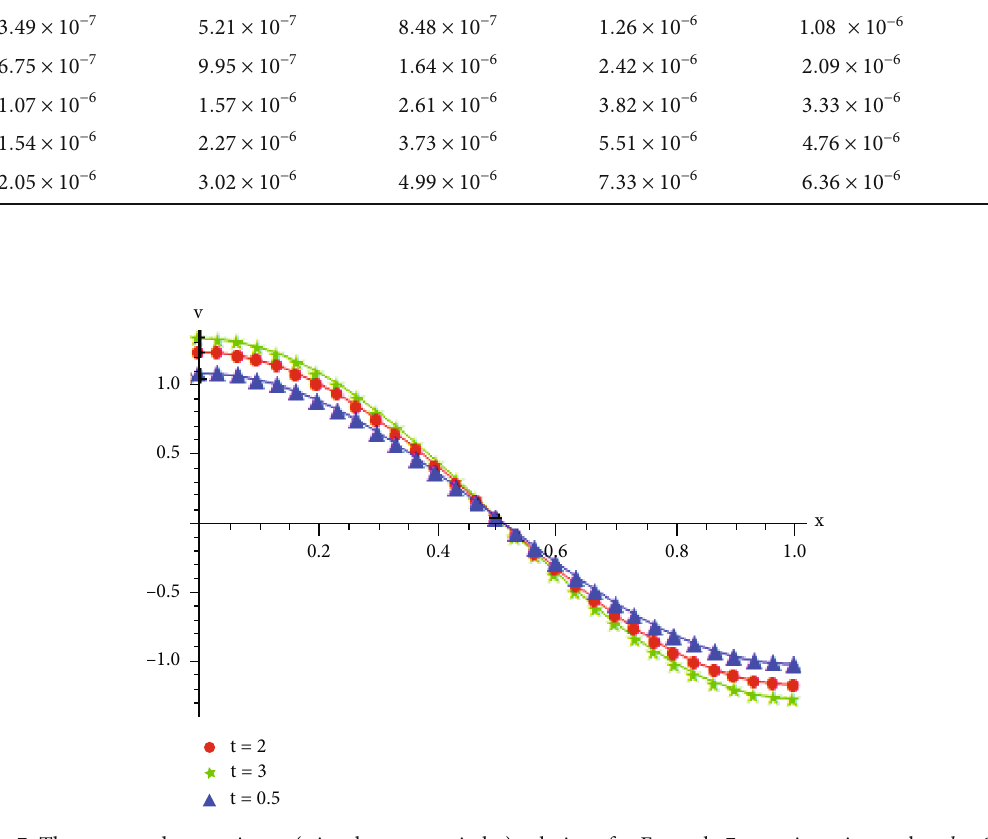
Figure 7: The exact and approximate (triangles, starts, circles) solutions for Example 7 at various times when h = 0 : 01